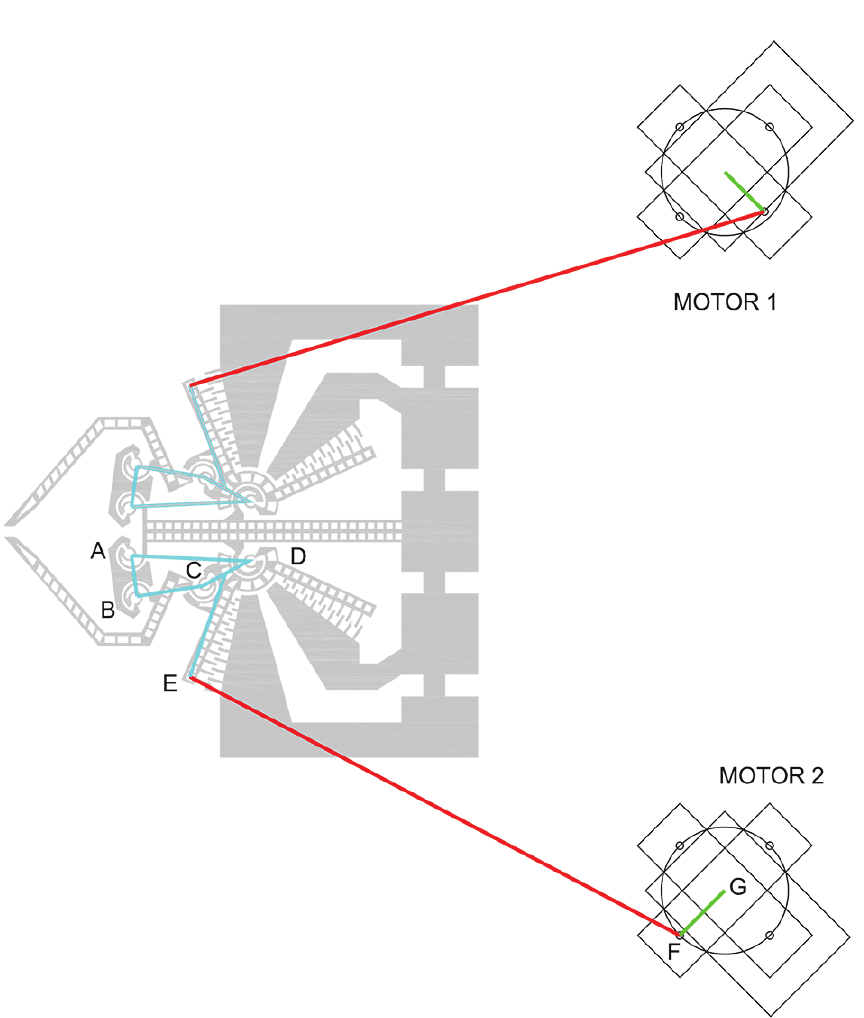
Figure 5. Actuation of the compliant mechanisms at the macroscale (second project).